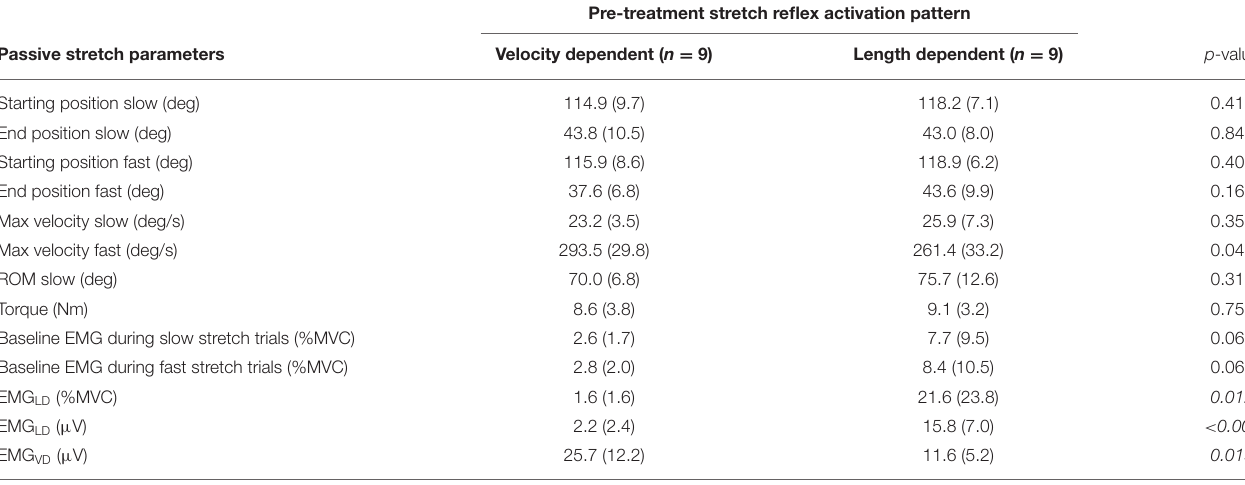
TABLE 3 | Average (and standard deviation) values of pre-treatment parameters in velocity-dependent and length-dependent muscles from the instrumented assessments during passive stretch. Pre-treatment stretch reflex activation pattern